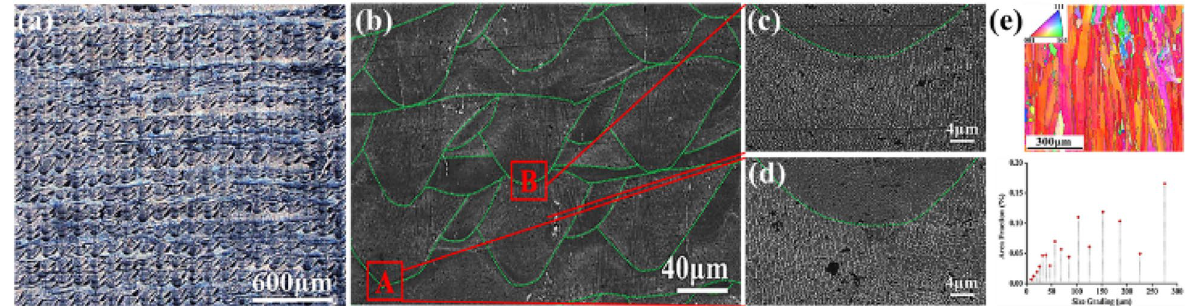
Figure 11 a The polished and etched YZ surface of the SLMed sample; b Cross-sectional view of molten pools; c Region B; d Region A; e Orientation map and size grading of the YZ